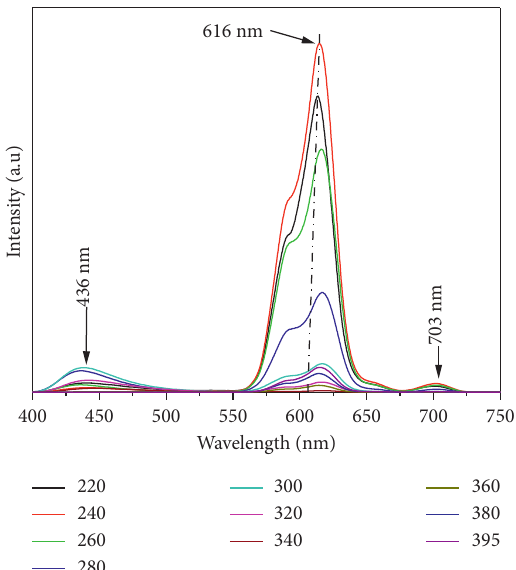
Figure 8: Emission spectra of BC: 2% Eu 3+ excited at various wavelengths.